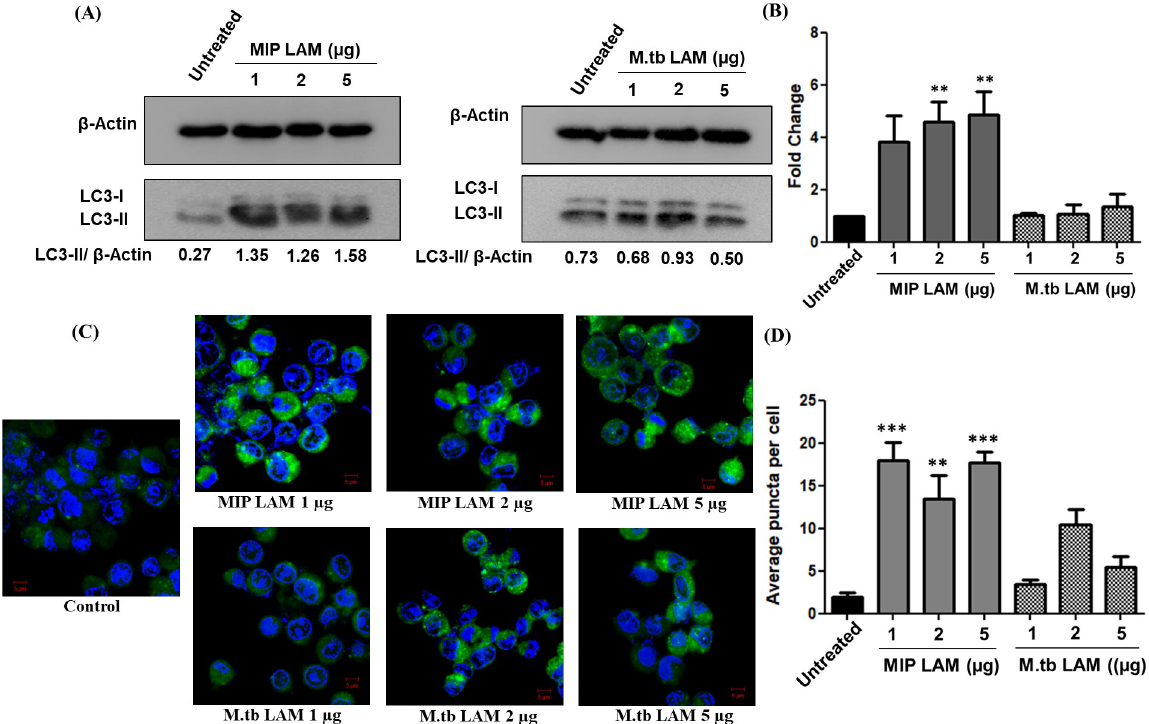
Fig 3. MIP-LAM stimulation results in significant induction of autophagy in macrophages. RAW 264.7 macrophages were stimulated with varying concentrations of MIP-LAM / M . tb- LAM for 4 h. Lysates were prepared and Western blotting was performed to analyze the expression level of LC3-II. (A) Shown are the representative blots depicting the level of lipidated LC3-II in MIP-LAM / M . tb- LAM stimulated macrophages. (B) Graph depicting the mean fold change ± range in LC3-II level in all the groups. (C) RAW cells stimulated with MIP-LAM / M . tb- LAM were analyzed for LC3 puncta formation by immunofluorescence. Shown are the merged images of GFP-LC3 (green) and DAPI (blue) taken at 63 X magnification. (D) Graph showing average puncta formed per cell in LAM stimulated macrophages. The scale bar represents 5 μ m. �� : P < 0.001, ��� : P <